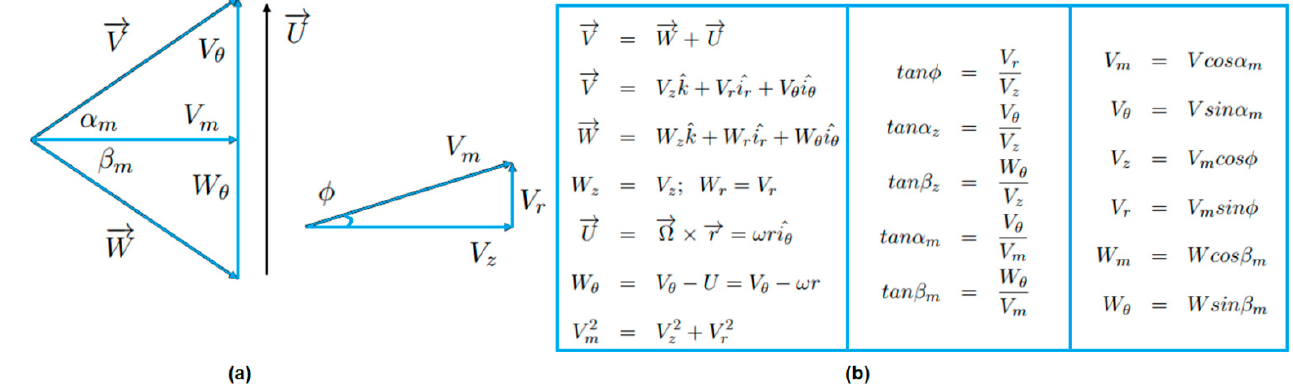
Figure 2. General velocity triangle is shown in ( a ) with streamline slope for high curvature and angle relationships with velocities are shown in ( b ).